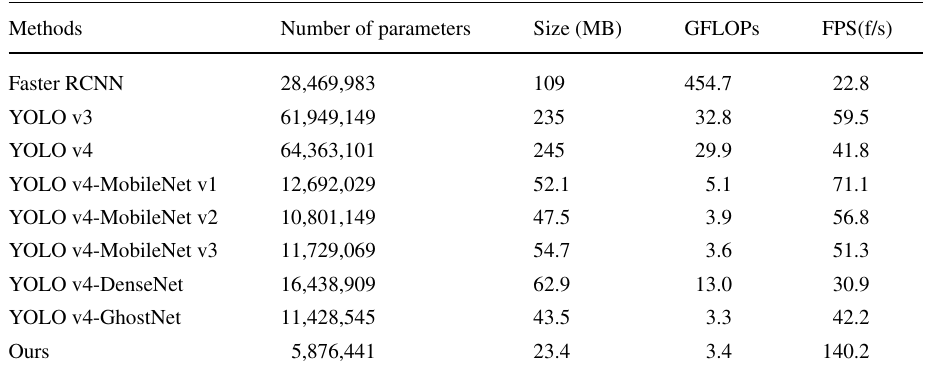
Fig. 9 Evaluation results of crack detection Table 2 Comparison of nine methods Methods Number of